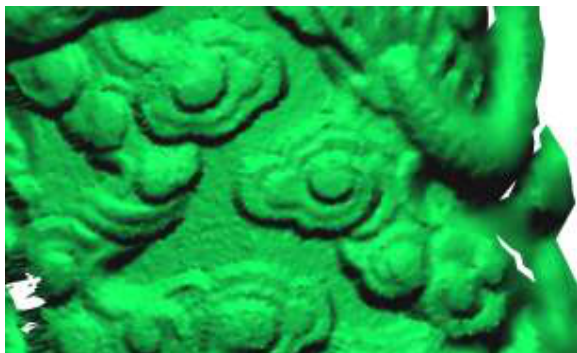
Figure 6. The difference of point cloud’s accuracy